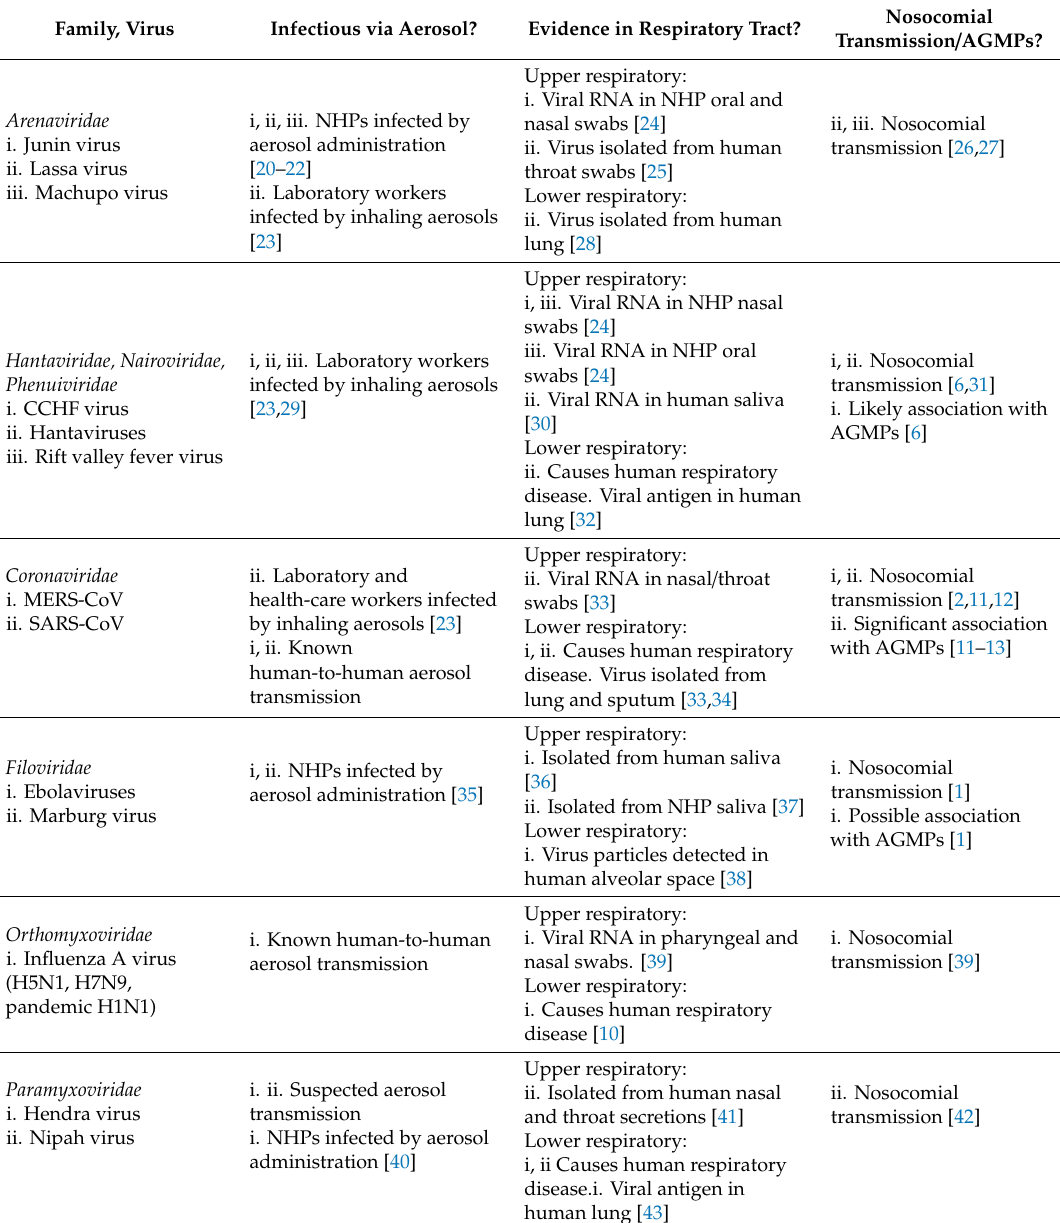
Table 2. Emerging viruses that may pose a high risk to health-care personnel when performing aerosol-generating medical